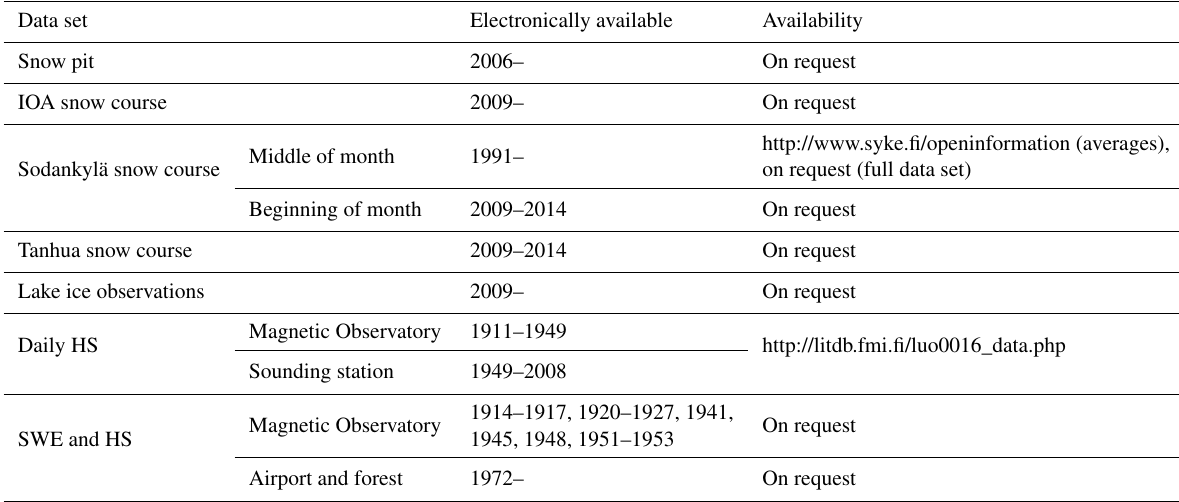
Table 3. Availability of the data during the time of the paper’s preparation. Different properties of data sets are marked under the data set column. The updated version of this table with direct links to the data sets can be found in